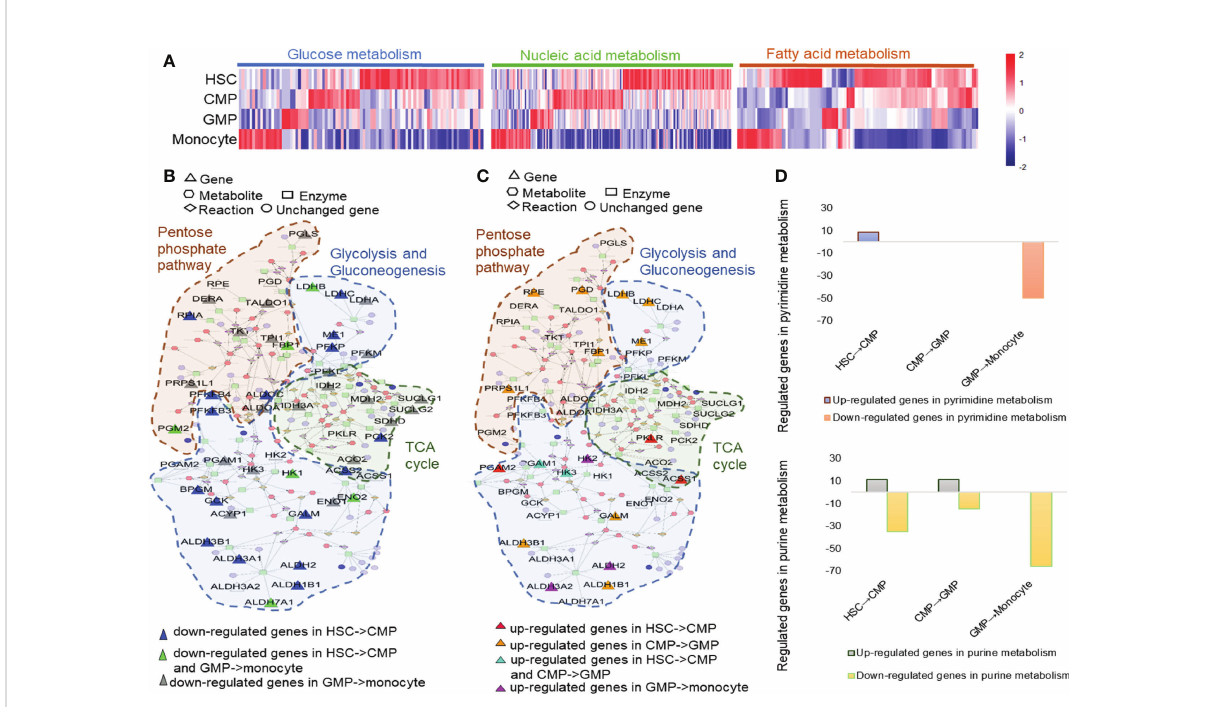
FIGURE 2 Metabolism changes during mouse HSC differentiation to monocytes. (A) Heatmap of glucose metabolism, nucleic acid metabolism and fatty acid metabolism-related genes based on their TPM values. The metscapes of the upregulated (B) and downregulated (C) genes in the metabolism networks of pentose phosphate pathway, glycolysis, and gluconeogenesis in mouse HSCs, CMPs, GMPs, and monocytes. (D) The regulated genes in pyrimidine metabolism and purine metabolism during monocyte